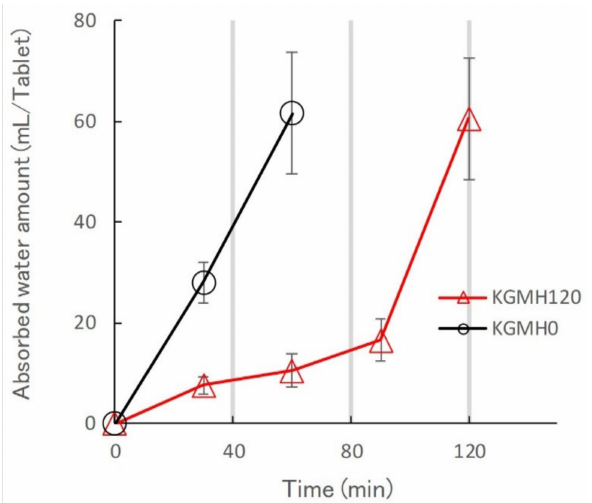
Figure 10. Effect of grinding on the water penetration rate of the KGMH0 and KGMH120 matrix